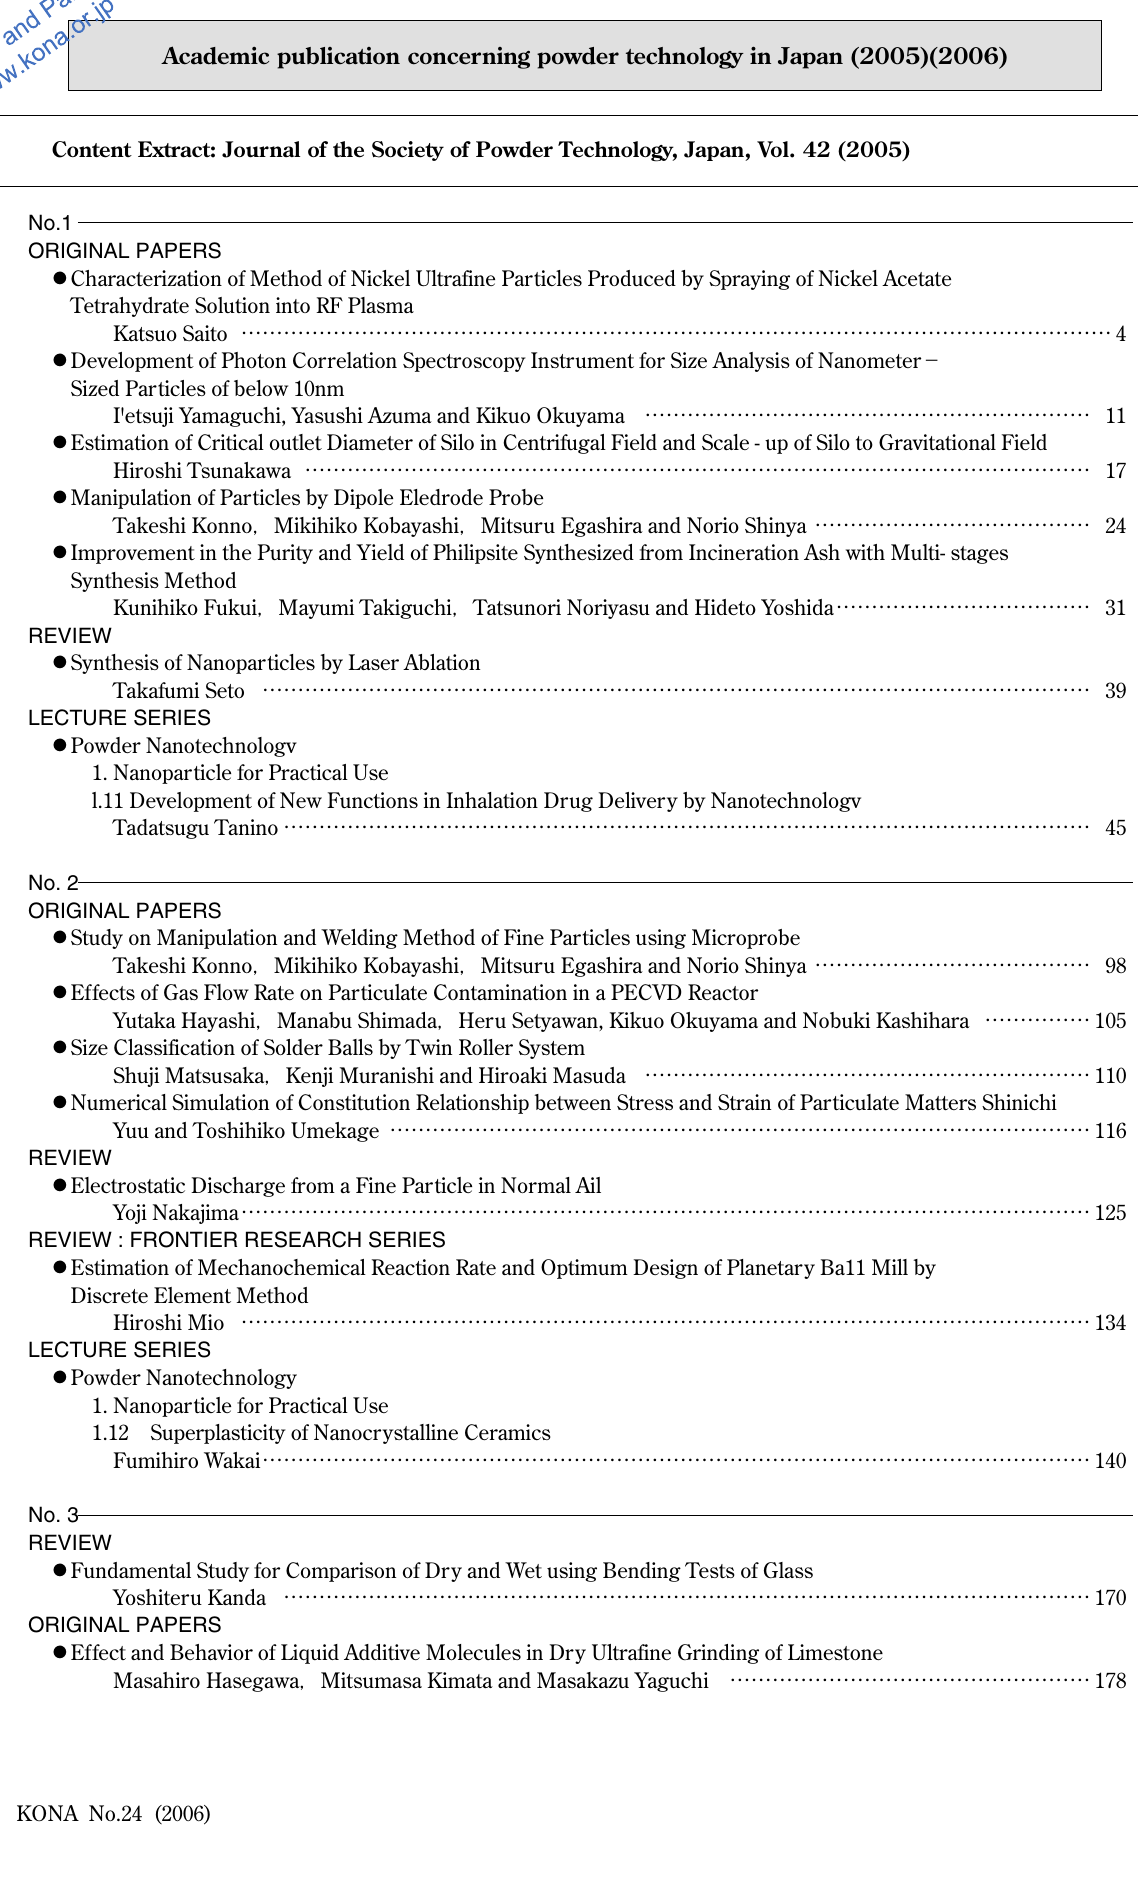
Sized Particles of below 10nm